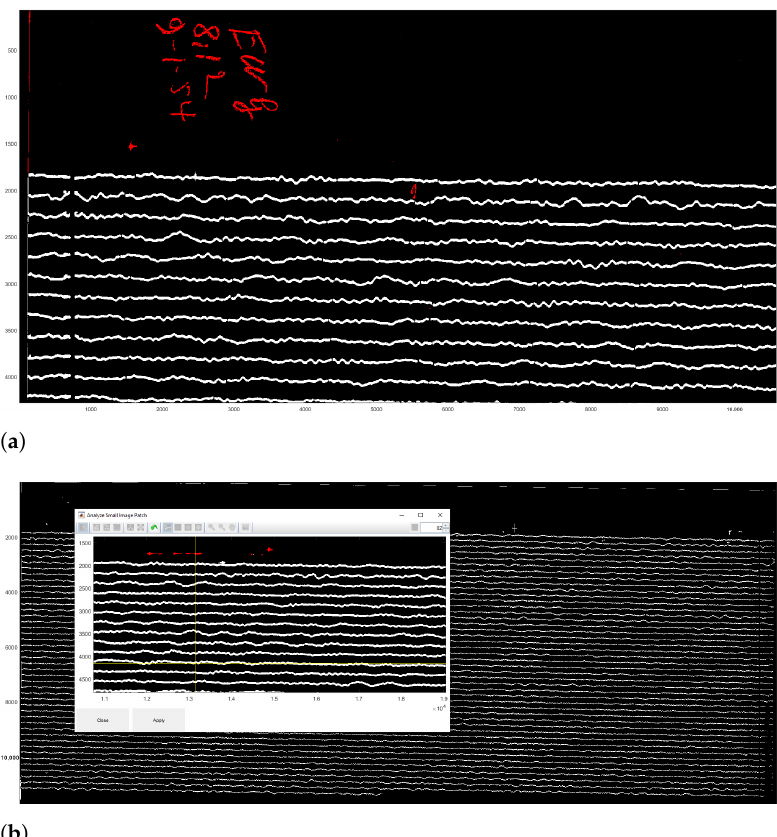
Figure 10. Results of the paper seismogram classification processed by DigitSeis. ( a ) Results of the classified seismogram with shown identified object categories (fragment): traces (white) and noise (red, here: handwritten annotations). ( b ) Small region analysis used for defining a smaller area of interest for closer examination of a border region of the